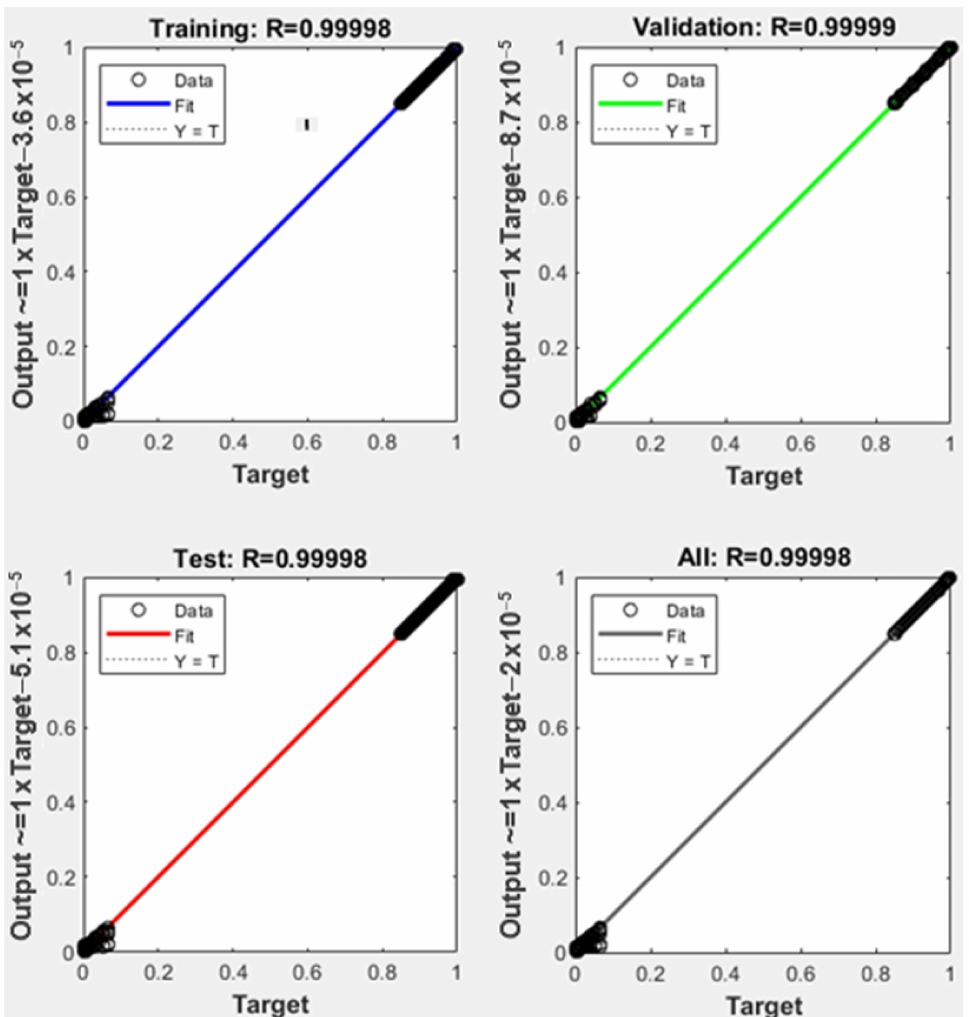
Figure 8. Neural network training results obtained for accurate localization involving the Sector 9